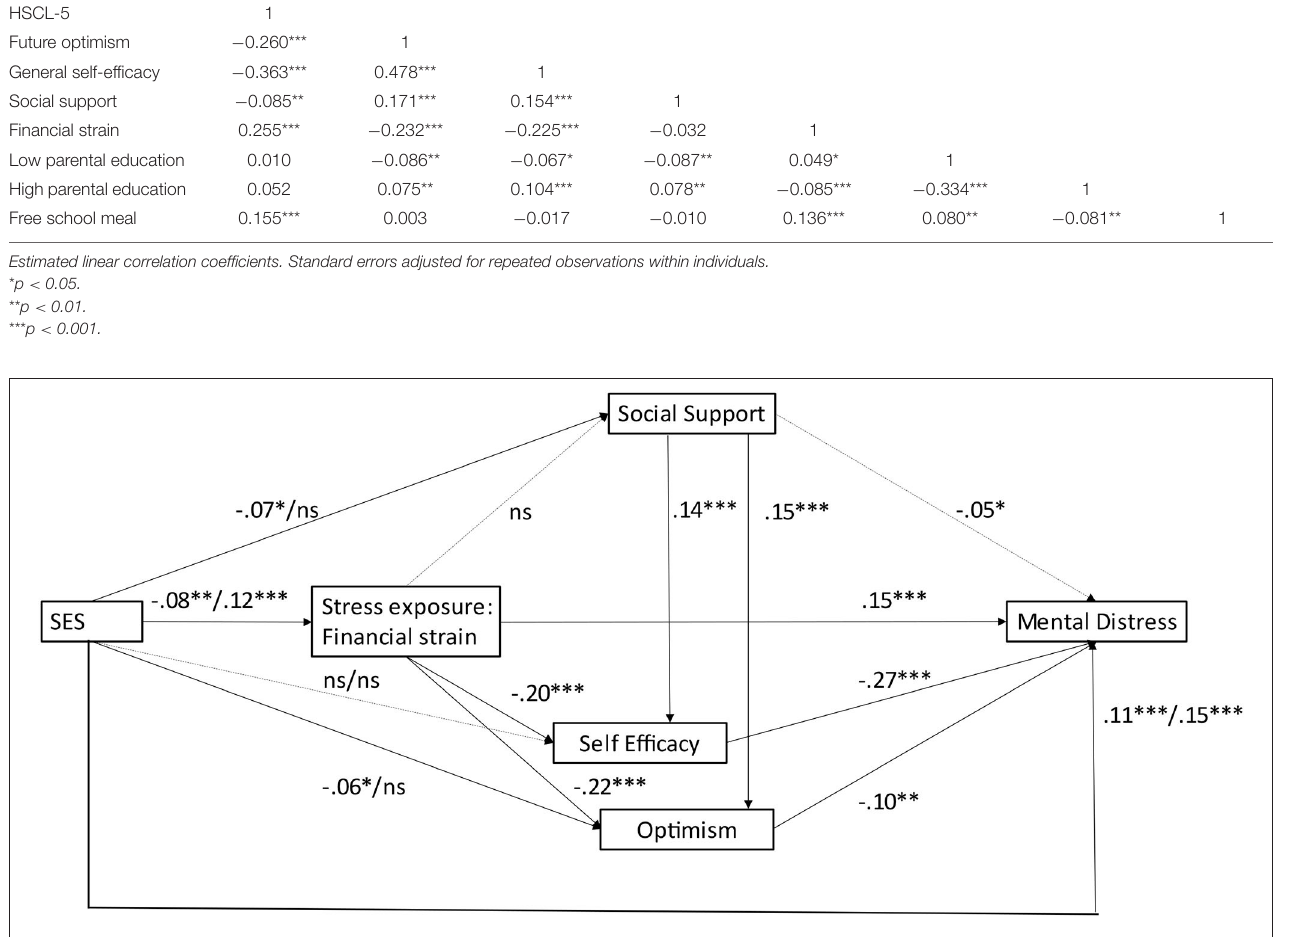
strain on mental distress. The strongest (negative) associations are observed between self-efficacy and mental distress ( β = − 0.269, p ≈ 0.000), followed by optimism ( β = − 0.102, p ≈ 0.000) and tendentially also social support ( β = − 0.047, p =